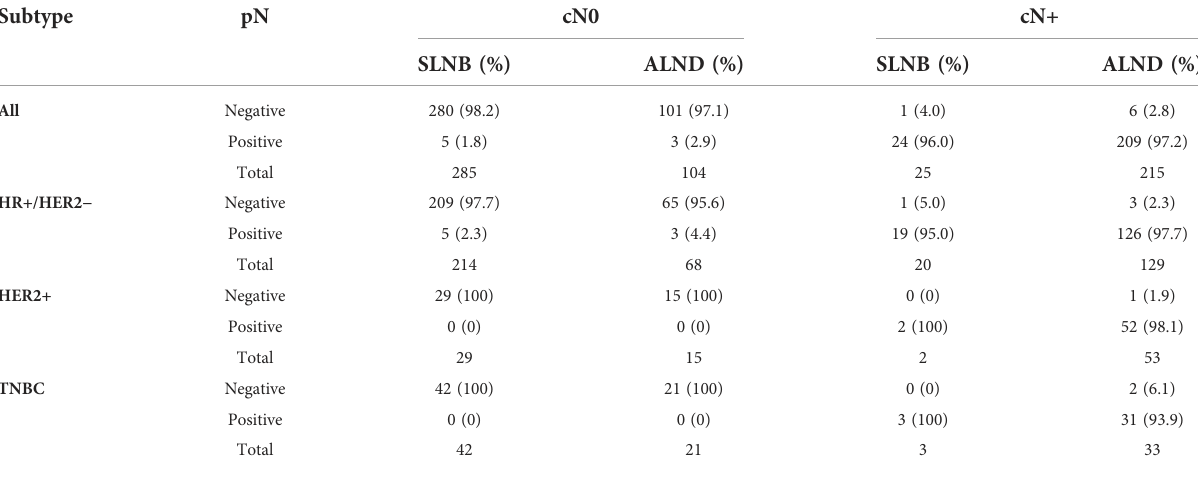
TABLE 2 Analysis of pathological axillary lymph node status in various axillary surgeries among cases with clinical lymph node negative (cN0) and clinical lymph node positive (cN+).